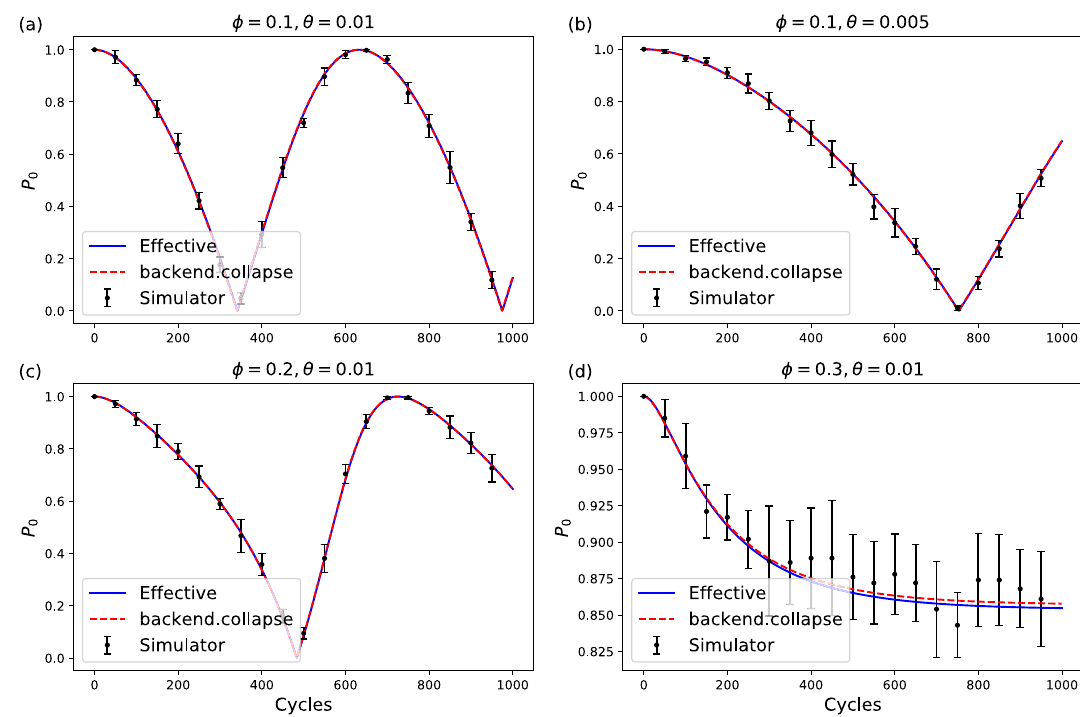
Figure 2. Compare simulation results with theoretical results. ( a – d ) Results with different φ and θ . The initial 0 state of the qubit is set to . P 0 is the probability that the qubit remains in the | � theoretical results with the effective non-Hermitian Hamiltonian. The red dashed lines are the results using functions that are only available in the simulator backend as a quick verification of the circuits. The dots with error bars are the simulated results. The n -cycle non-Hermitian circuit is repeated 100 times to get a single estimation of P 0 . Then the whole process is repeated 10 times to get the mean value of P 0 and the error